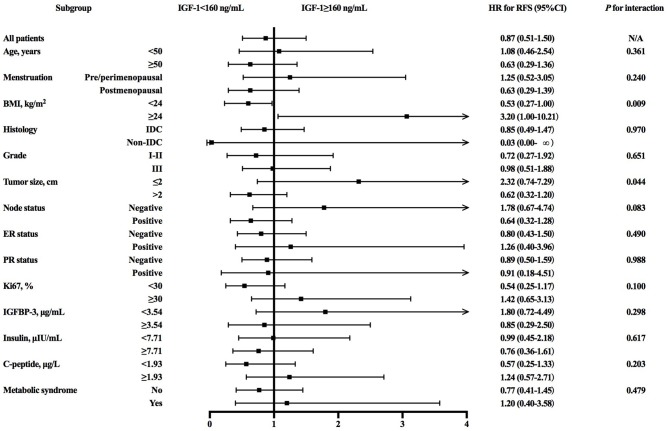
Forest plots and interaction analysis for RFS in HER2-positive breast cancer patients with different level of IGF-1. RFS, recurrence-free survival; HER2, human epidermal growth factor receptor 2; IGF-1, insulin-like growth factor-1; HR, hazard ratio; CI, confidence interval; BMI, body mass index; IDC, invasive ductal carcinoma; ER, estrogen receptor; HR, hormonal receptor; IGFBP-3, insulin-like growth factor binding protein-3.